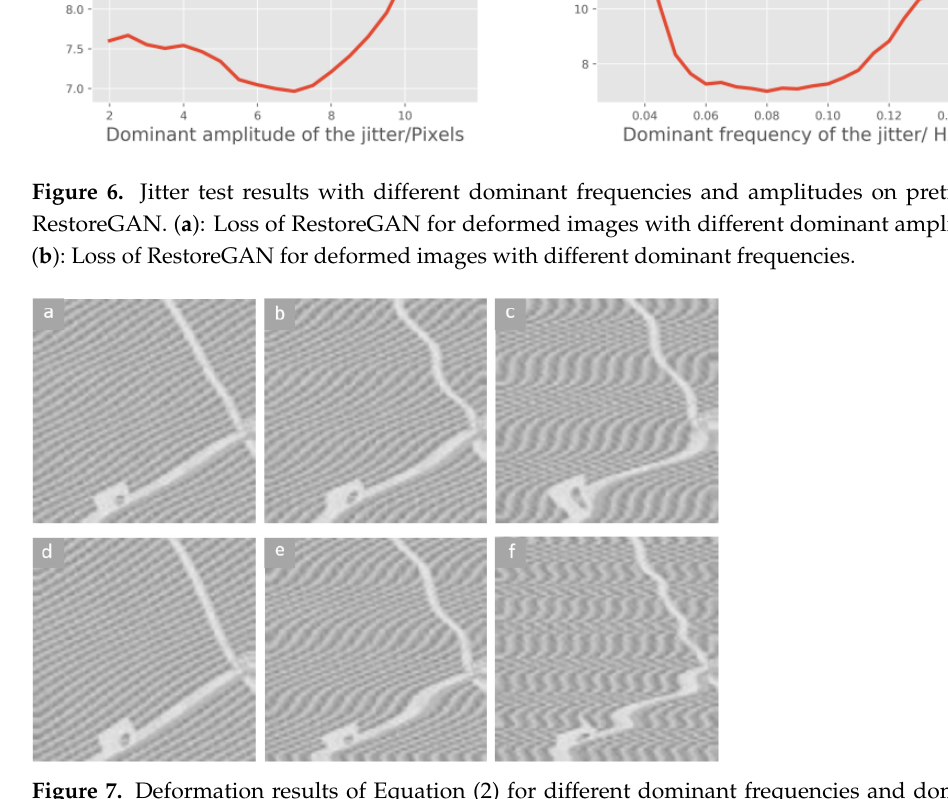
Figure 7. Deformation results of Equation (2) for different dominant frequencies and dominant amplitudes. ( a ): Amplitude = 2 pixels; ( b ): Amplitude = 6 pixels; ( c ): Amplitude = 11 pixels; ( d ): Frequency = 0.03 Hz; ( e ): Frequency = 0.07 Hz; ( f ): Frequency = 0.13